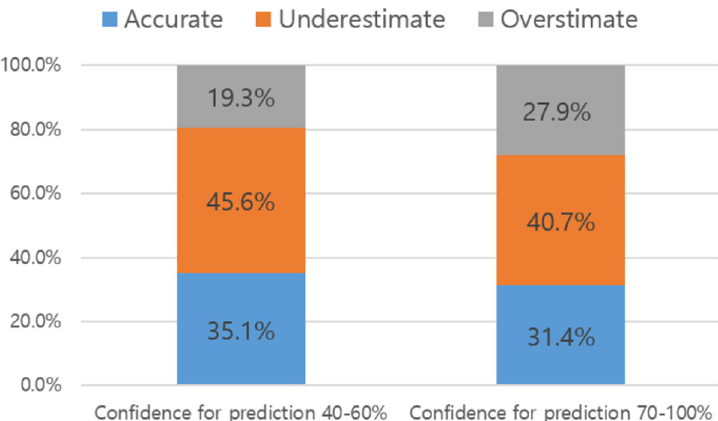
Fig 1. Accuracy of clinician prediction of survival by prognostic confidence in prediction. a P -value was 0.359 by chi-square test. b Accurate estimation was defined as clinician prediction of survival being within ± 33.3% of actual survival. c Clinicians’ prognostic confidence was measured by a percent scale from 0% (not at all) to 100% (full